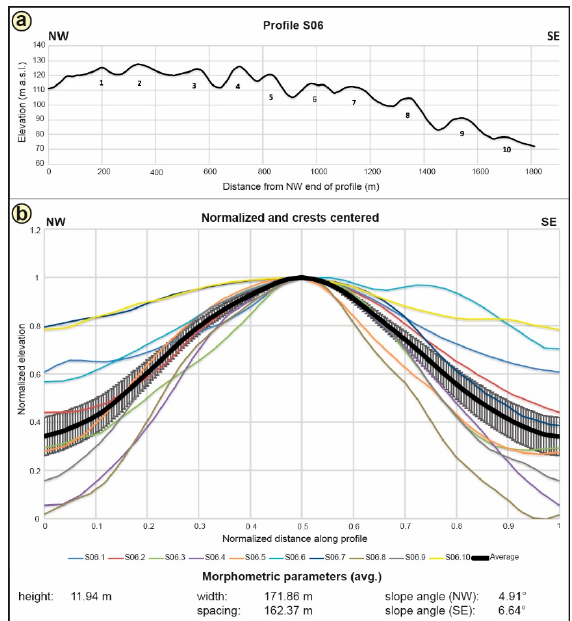
Figure 9. Profile S06 is shown as elevation profile from its distal (NW) to proximal (SE) end with the numbered ridge crests ( a ); The stacked profiles of the elevation profile include the average graph (thick black graph) and error bars (±1 standard deviation) ( b ). The morphometric parameters—mean height, width, spacing, and slope angles—are shown below.